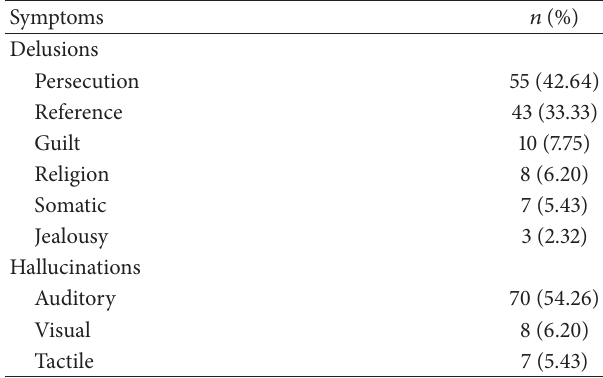
Table 3: Profile of psychotic symptoms in patients with psychotic major depression ( 𝑁 = 129